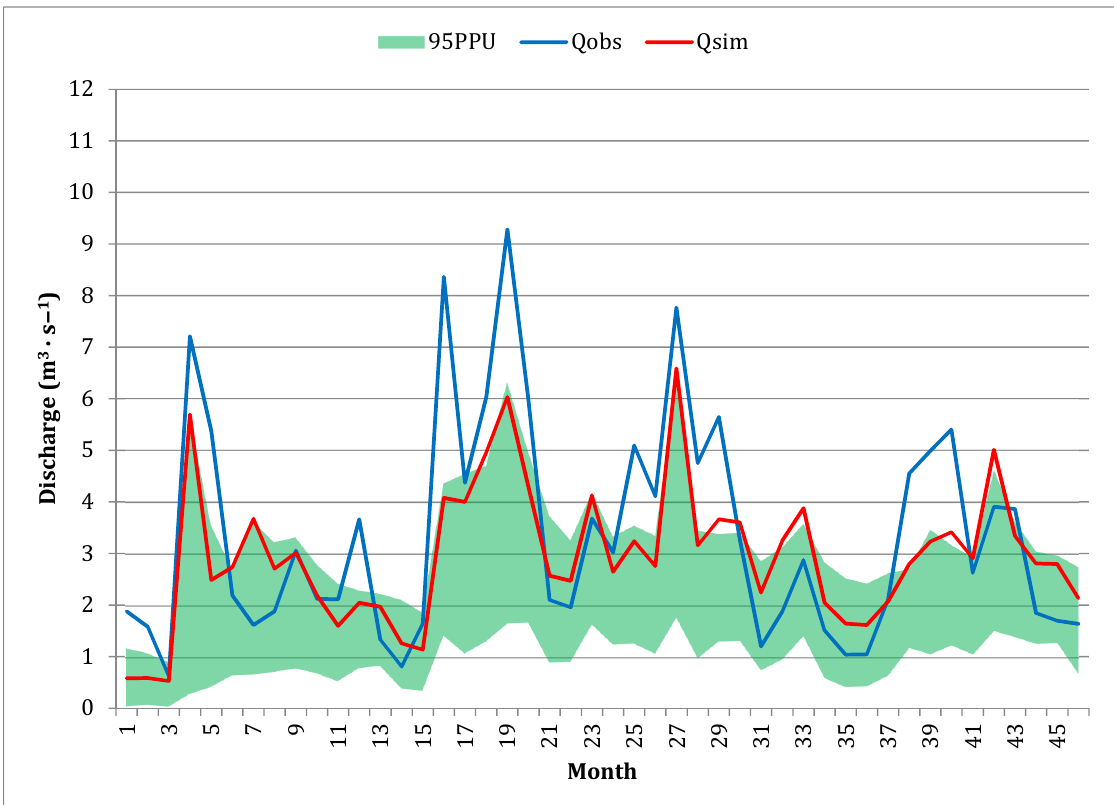
Figure 7. The 95PPU plot between observed and best simulated discharges after the validation procedure.